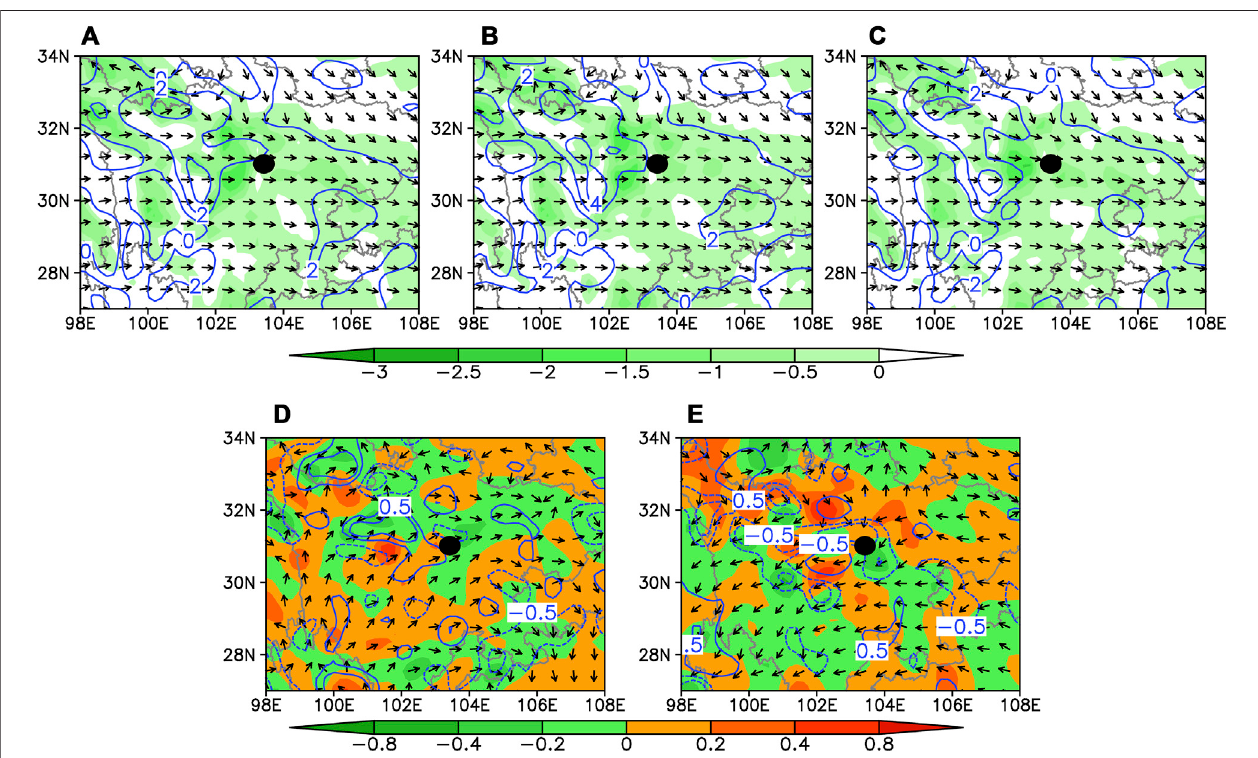
FIGURE 13 | The 48-h average water vapor fl ux (vectors, units: 10 – 3 g hPa − 1 cm − 1 s − 1 ), divergence of water vapor fl ux (shading, units: 10 – 8 g hPa − 1 cm − 2 s − 1 ), vertical velocity (blue lines, units: 10 – 2 m s − 1 ) at 500 hPa from 00:00 UTC on May 12 to 00:00 UTC on May 14, 2008 for (A) the CTL experiment, (B) the TMP+1.5 experiment, (C) the TMP − 1.5 experiment, (D) the difference between the CTL and TMP+1.5 experiments and (E) the difference between the CTL and TMP − 1.5 experiments. The black dots denote the epicenter of the